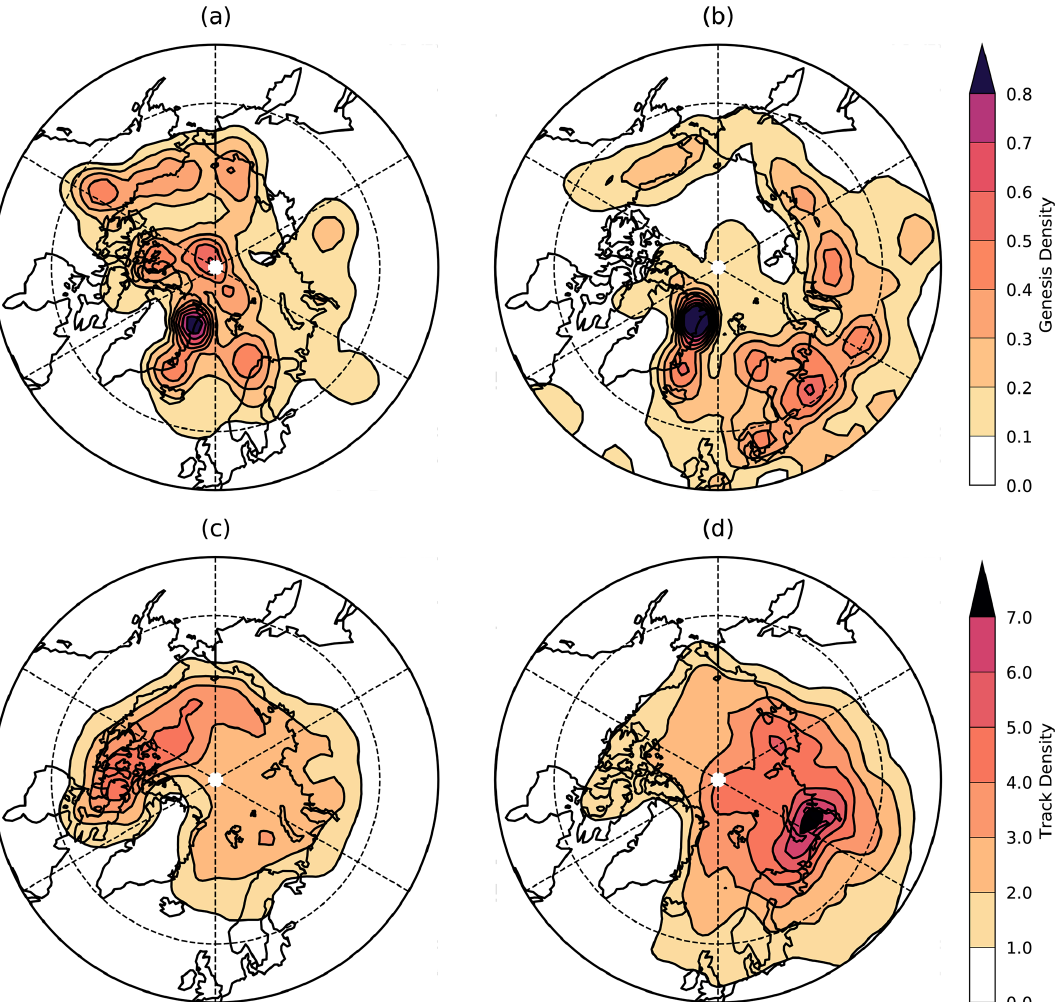
Figure 7. Genesis and track densities of Arctic cyclones matched and unmatched to a TPV: (a) matched and (b) unmatched cyclone genesis densities and (c) matched and (d) unmatched cyclone track densities during the extended-summer season between 1979 and 2018. Units are the number per unit area per season where the unit area is equivalent to a 5 ◦ spherical cap ( ∼ 10 6 km 2 ). The total number of tracks is 302 for the matched cyclones and 431 for the unmatched cyclones. Maps are orientated with 0 ◦ longitude at the